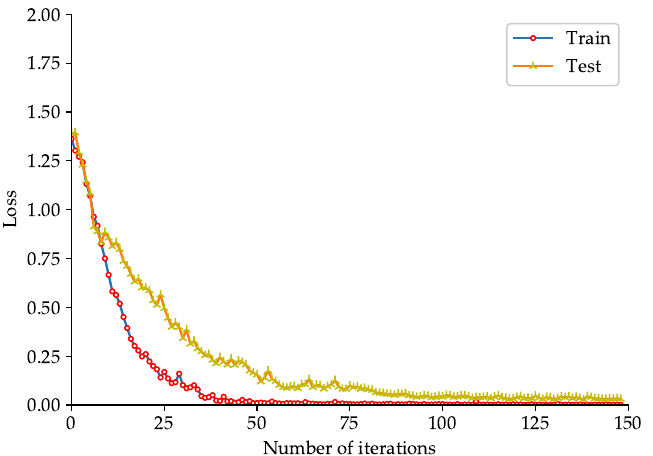
Figure 8. Loss function curve of the fault diagnosis model based on the improved 1D LeNet-5